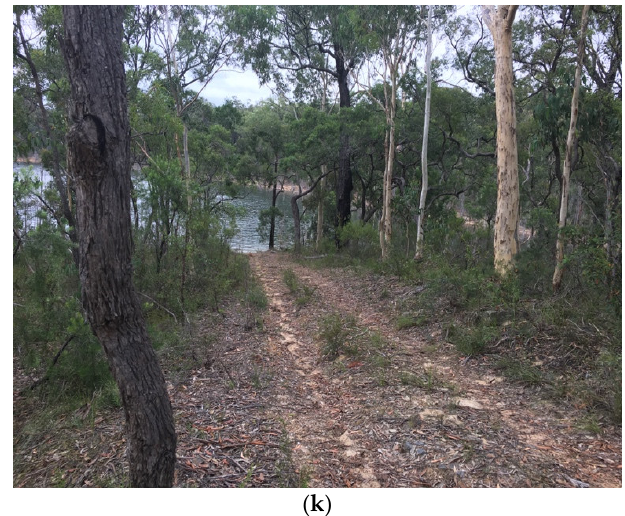
Figure 3. The eleven distinct areas of four main habitat types where horses resided. ( a ) Open grassland 1. ( b ) Open grass- land 2. ( c ) Open grassland 3. ( d ) Open grassland 4. ( e ) Disturbed open woodland. ( f ) Riparian 1. ( g ) Riparian 2. ( h ) Wood-